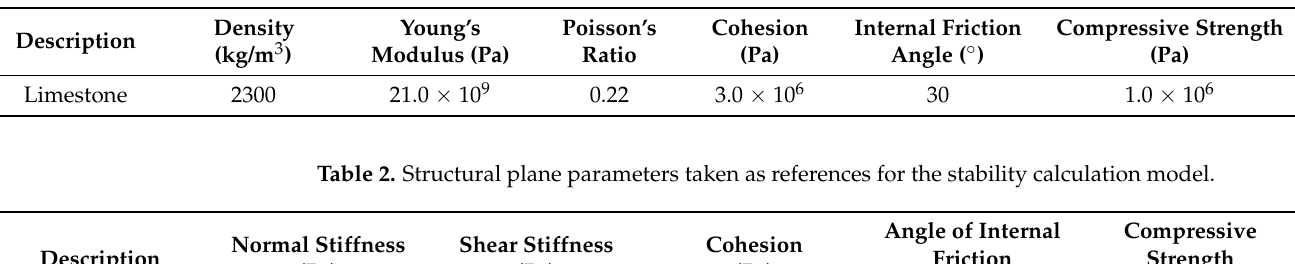
Figure 1. Schematic diagram of the numerical analysis model. Table 1. Rock mass parameters taken as references for the stability calculation model.